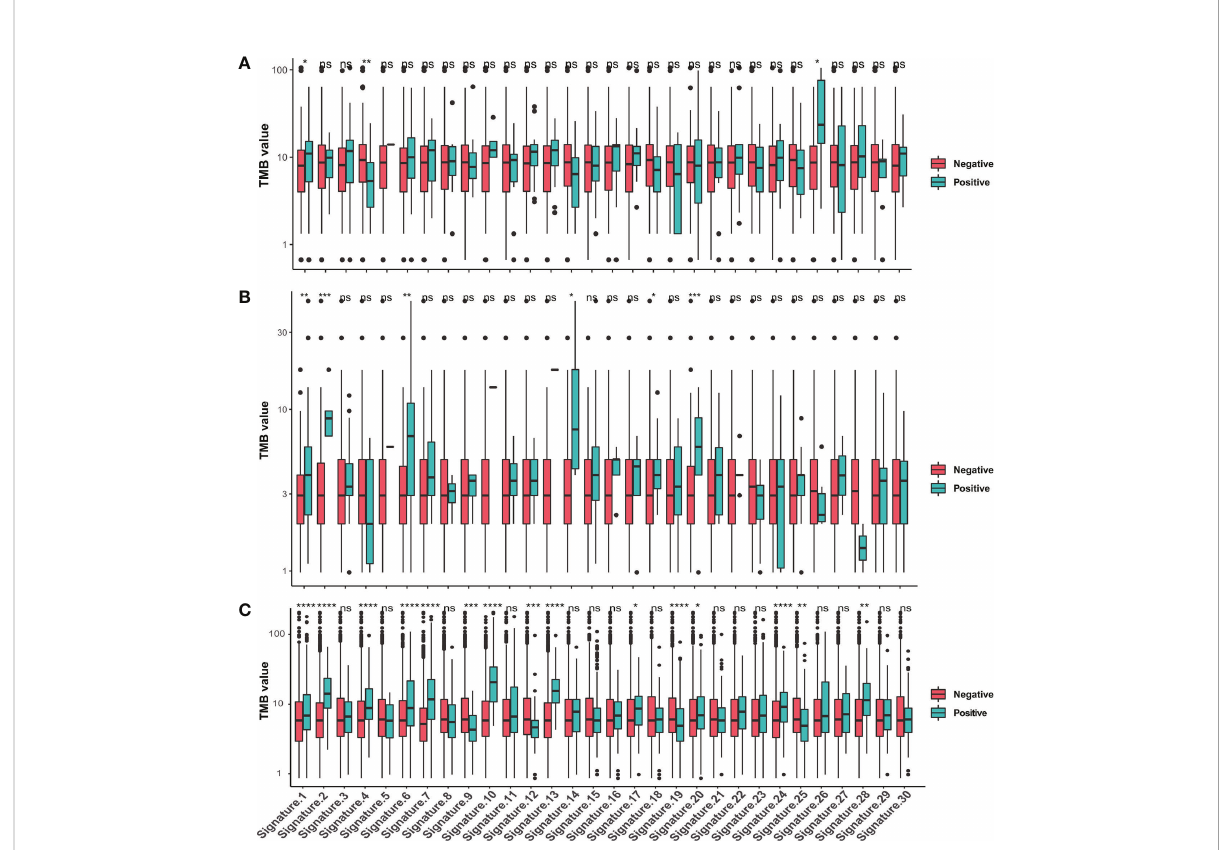
FIGURE 9 Correlations between TMB values and the 30 COSMIC mutational signatures. Comparison of TMB values in patients with and without COSMIC mutational signatures in (A) our BTC cohort, (B) the MSKCC BTC cohort, and (C) the MSKCC pan-cancer cohort. * p < 0.05; ** p < 0.01; *** p < 0.001; **** p < 0.0001. TMB, tumor mutational burden; COSMIC, Catalogue of Somatic Mutations in Cancer; BTC, biliary tract cancer; MSKCC, Memorial Sloan Kettering Cancer Center. ns, no signi fi